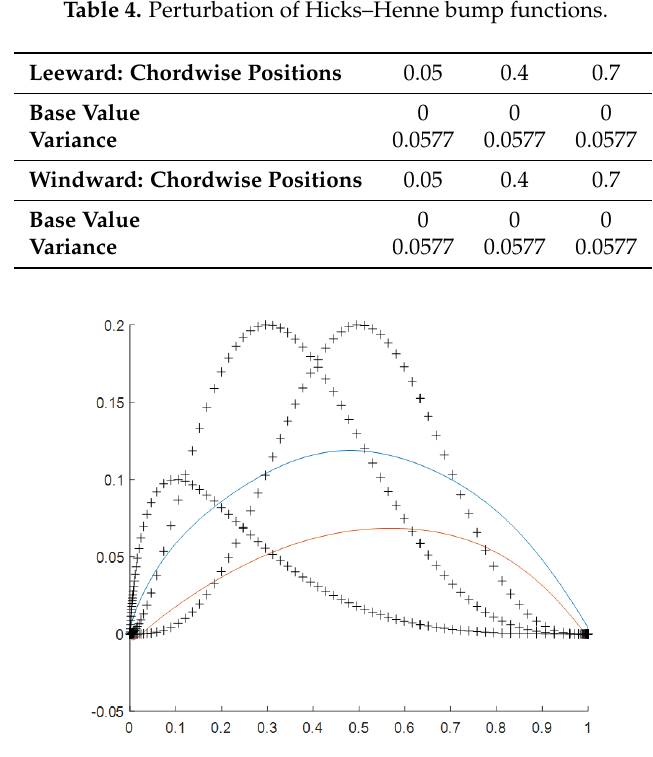
Table 4. Perturbation of Hicks–Henne bump functions.